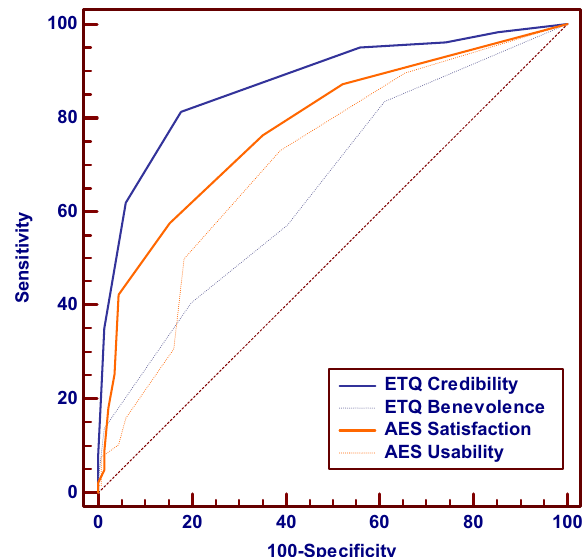
Fig. 3 ROC curves of the four dimensions of trust and acceptance: benevolence, credibility, usability, and satisfaction, to classify engaged and non-engaged